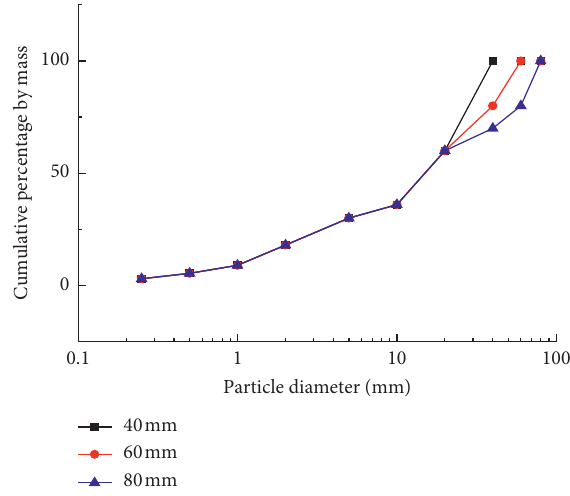
Figure 3: Grading curves of samples with different contents of coarse particles.